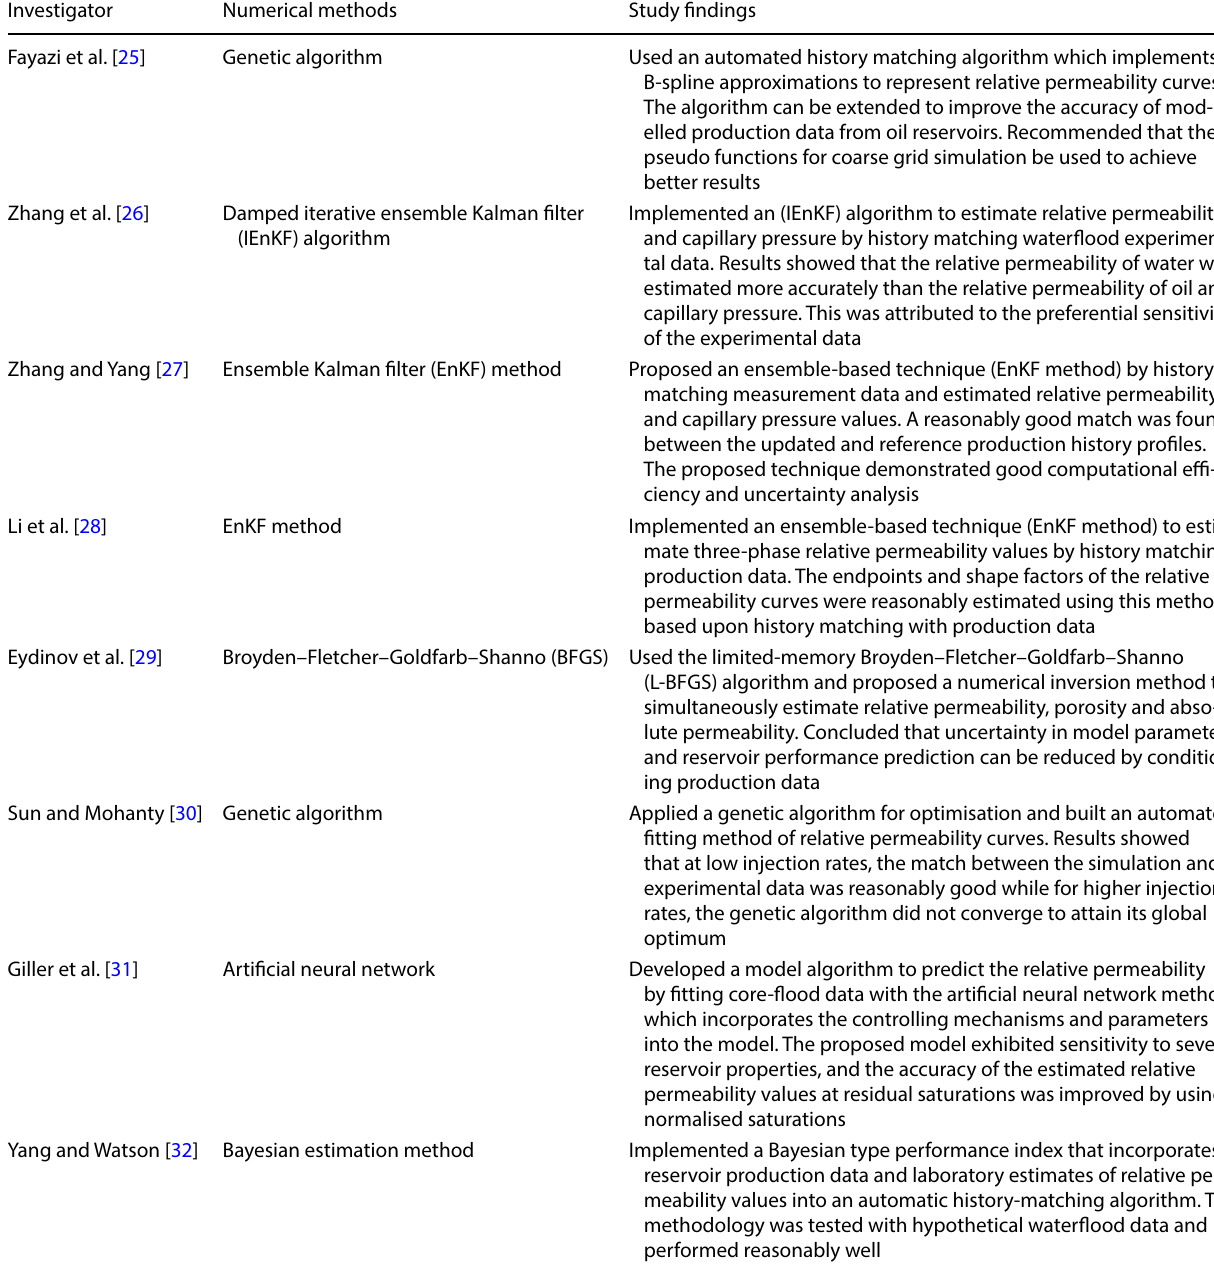
Table 2 Numerical methods proposed by different investigators to estimate relative permeability Investigator Numerical